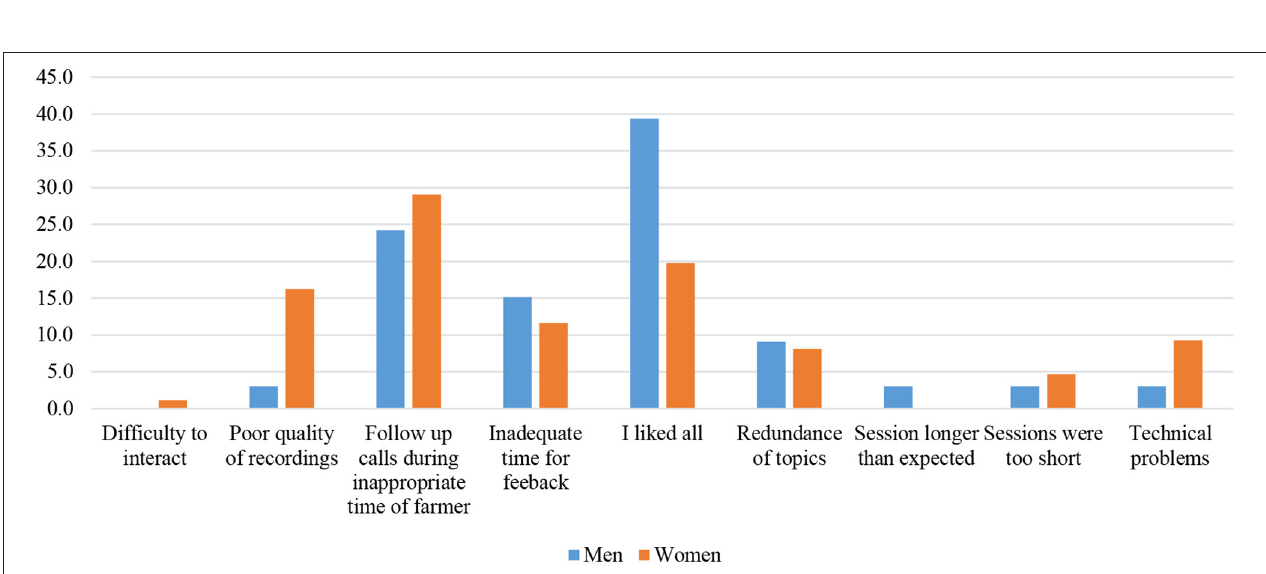
FIGURE 7 | What didn’t you like about the mobile training? ( n =